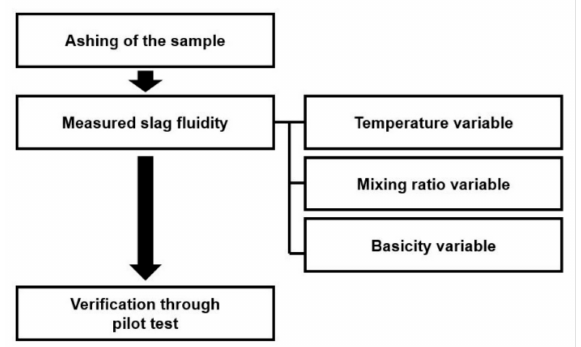
Figure 2. Schematic of the research